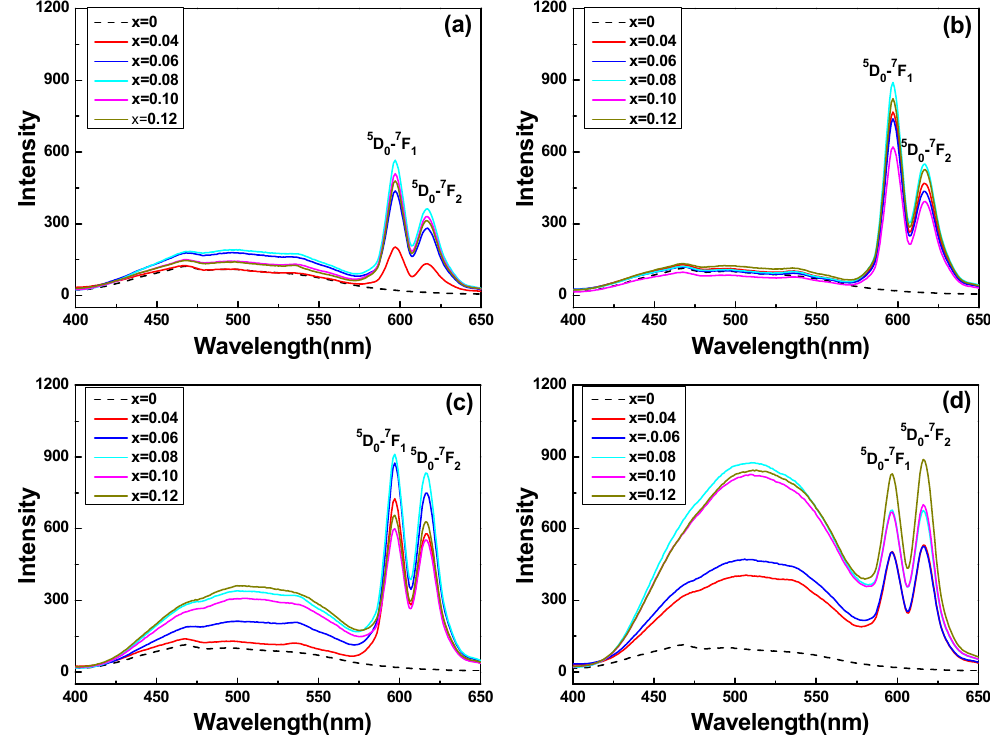
Figure 3. Emission spectra of Sr 2 − x Eu x ZnMoO 6 phosphors synthesized at ( a ) 900 °C; ( b ) 1000 °C; ( c ) 1100 °C; and ( d ) 1200 °C, respectively.